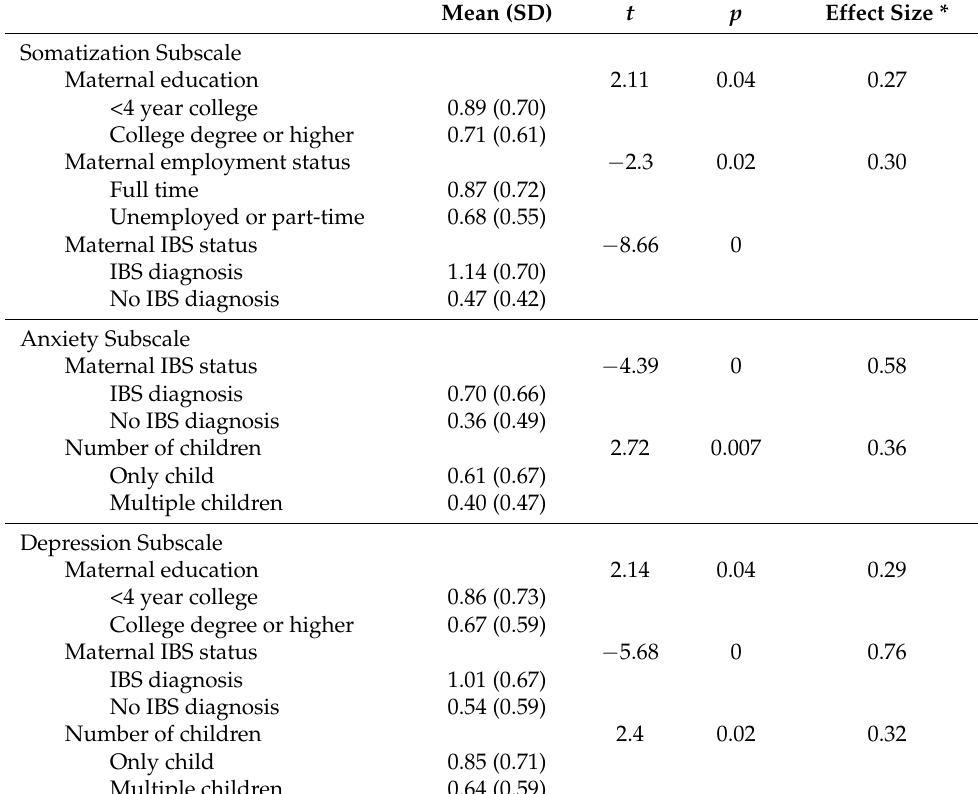
Table 4. Significant t -test findings by demographics on SCL-90